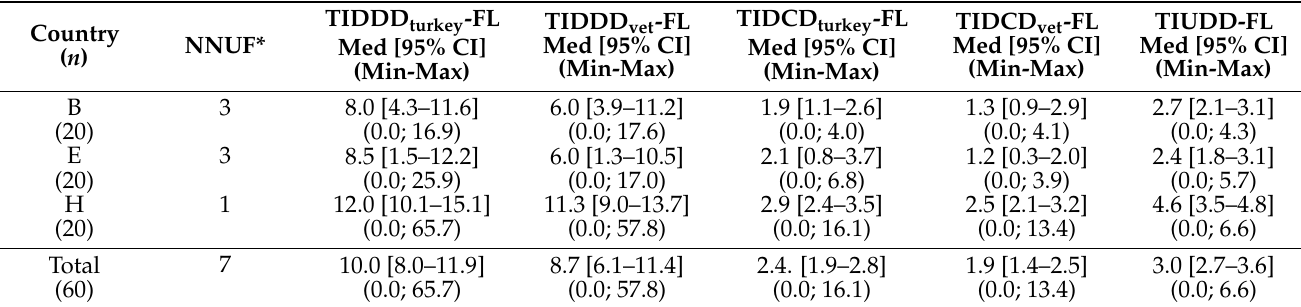
Table 3. Antimicrobial usage quantified using treatment incidence (TI). TI is summed up at flock level and expressed